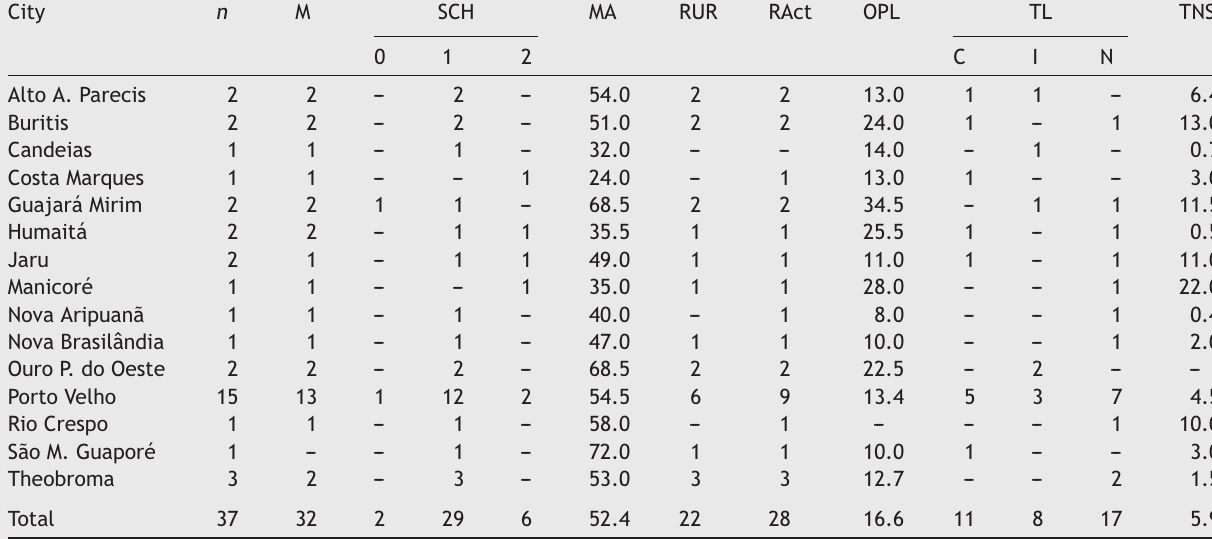
Epidemiological data of study participants in POC, city of Porto Velho, AC, Brazil.